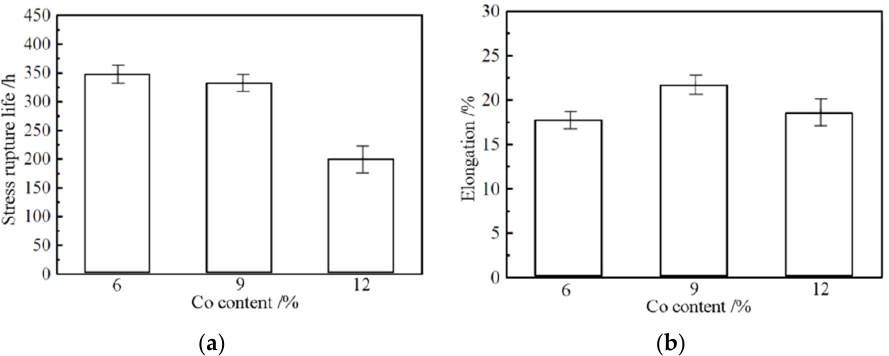
Figure 6. Influence of Co content on the stress rupture properties of the alloy at 1100 °C/137 MPa: ( a ) stress rupture life and ( b ) elongation.